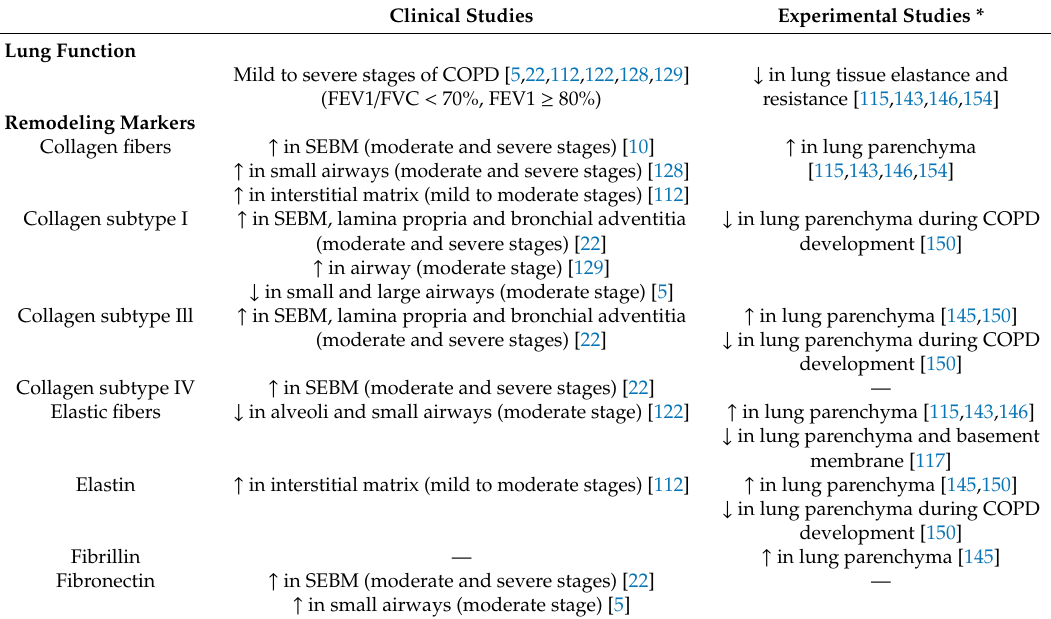
Table 3. Lung function changes and markers of extracellular matrix (ECM) remodeling in COPD. Clinical